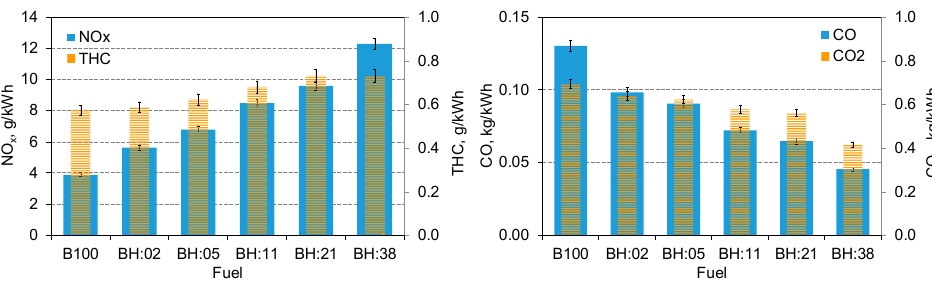
Figure 8. Specific emission of NO x , THC, CO and CO 2 .